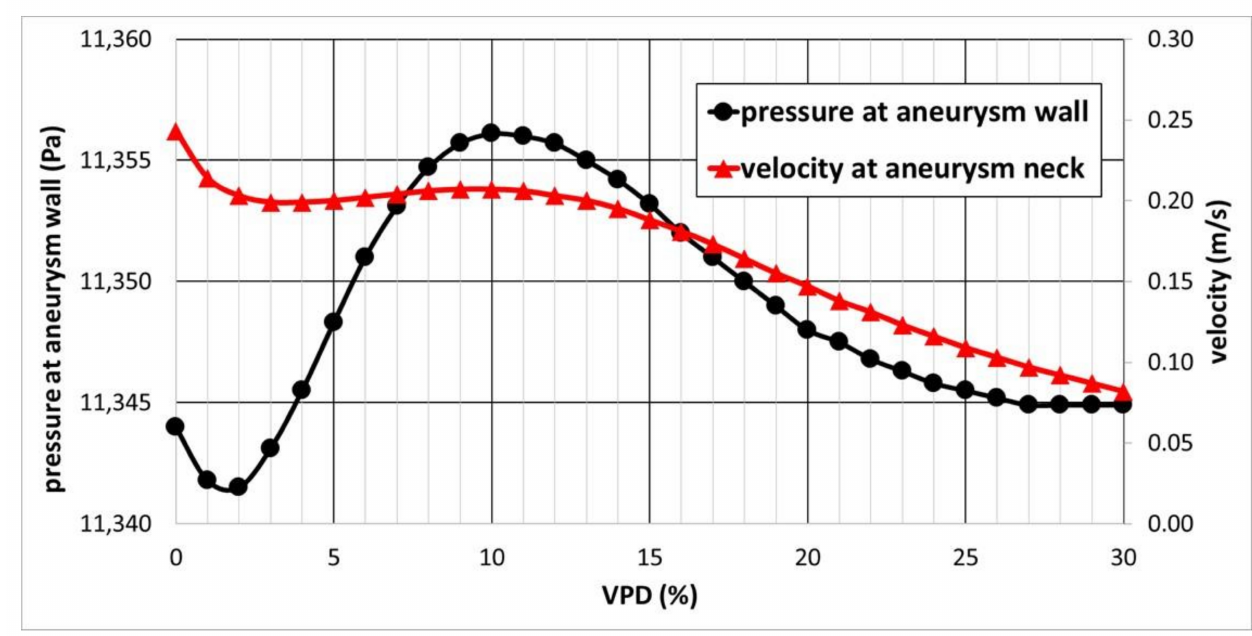
Figure 9. Area-averaged pressure at the aneurysm wall and area-averaged velocity at the aneurysm neck for each analyzed VPD; stationary